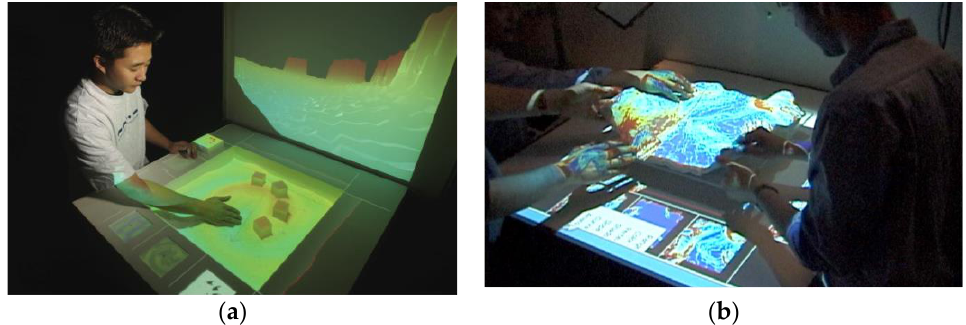
Figure 36. Manipulation with SandScape and projected onto the surface of sand in real-time ( a ) [61], Illuminating Clay in use ( b ) [62].